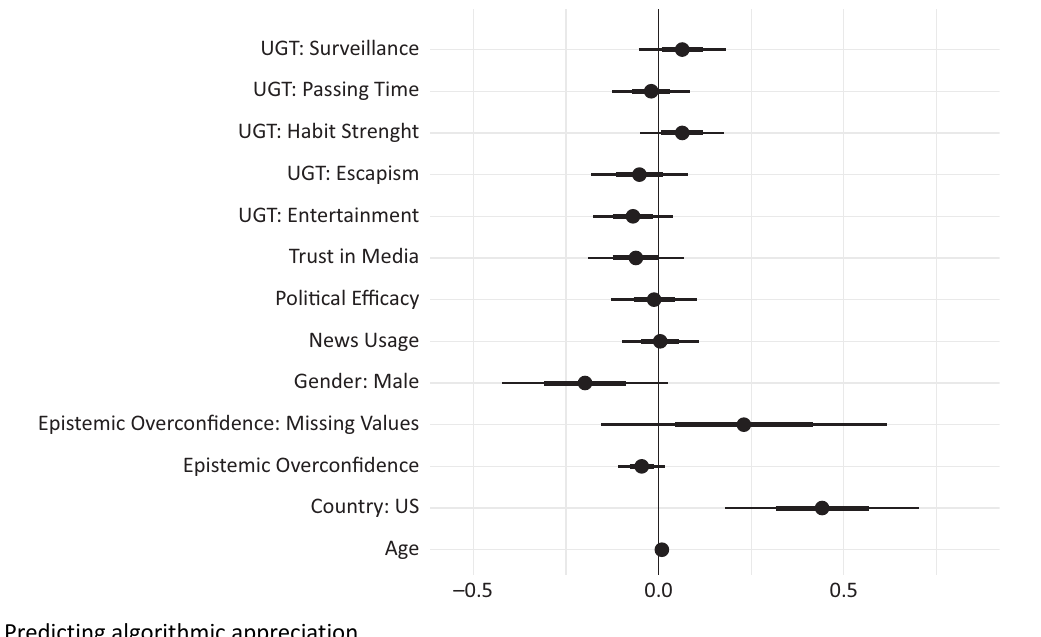
Figure 4. Predicting algorithmic